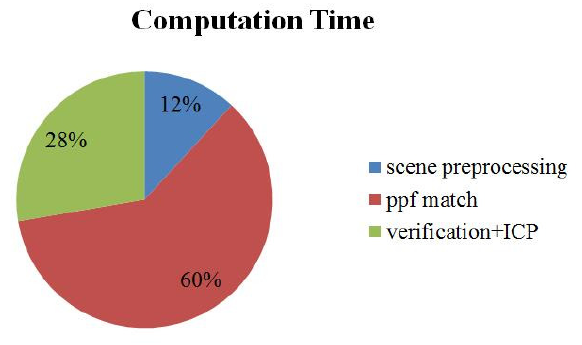
Figure 14. Components of the computation time of our algorithm.